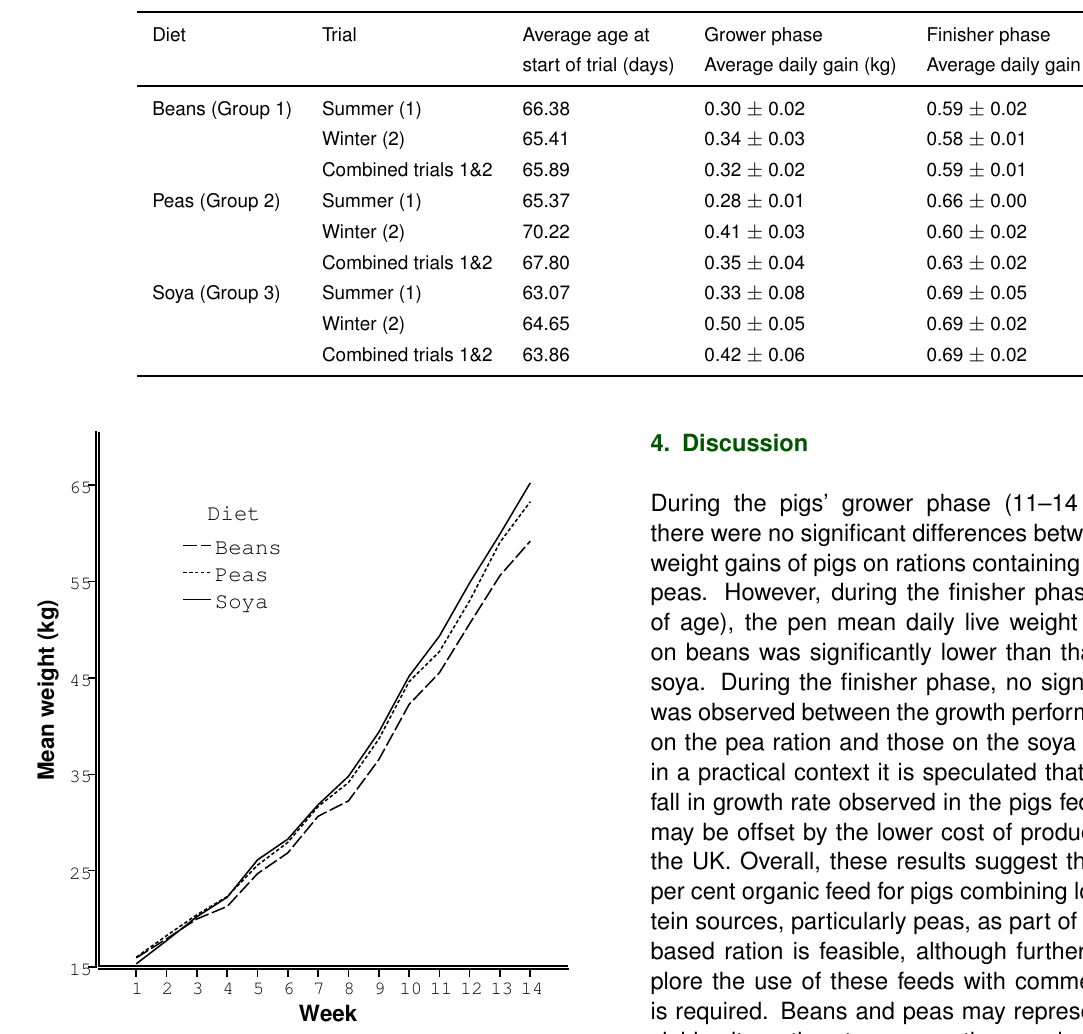
Table 5. Pen mean ( ± standard error) daily live weight gains (DLWGs) of pigs during grower and finisher phases when fed silage-based diets supplemented with either soya (control), beans or peas.